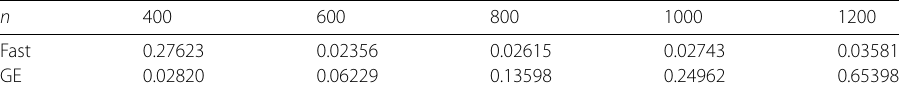
Table 1 Temporal performance for the proposed (fast) algorithm and Gaussian elimination (GE) when solving the direct problem n